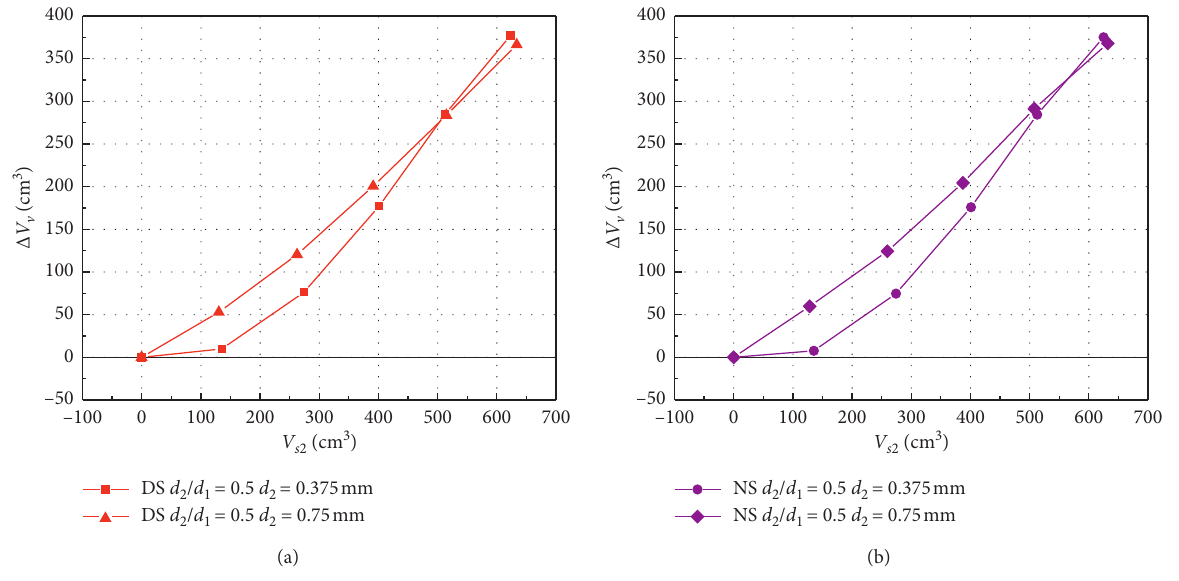
Figure 11: Comparison of Δ V